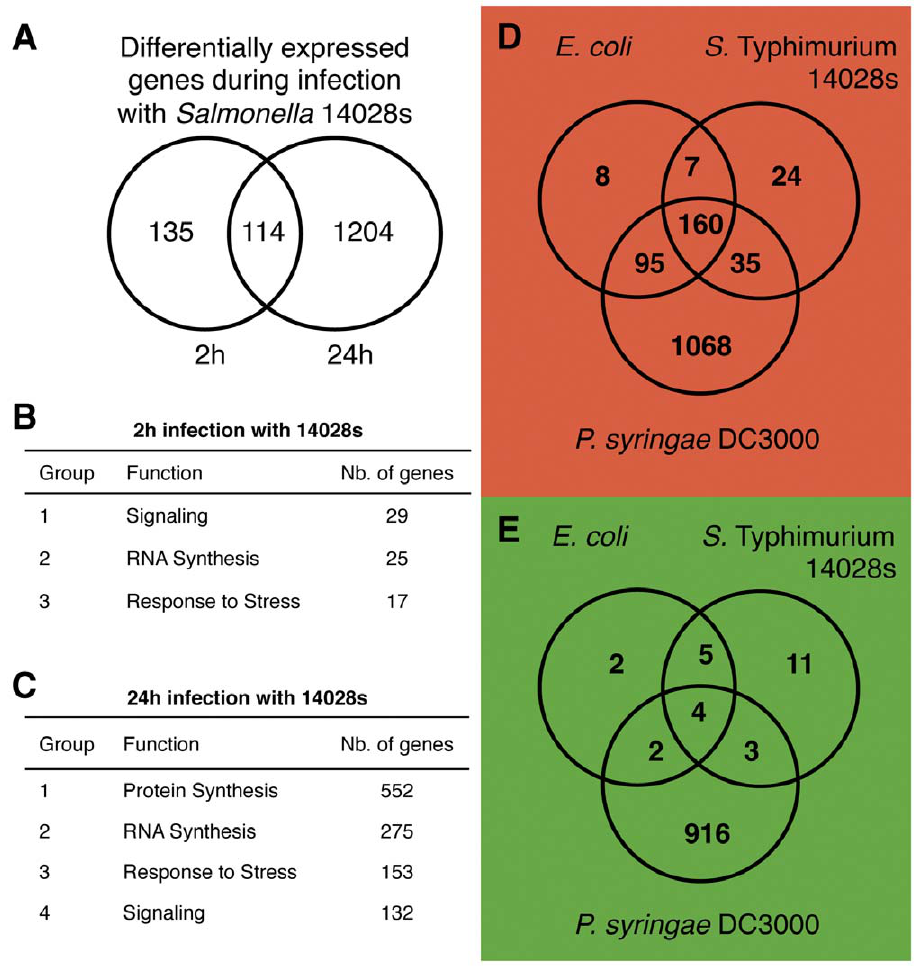
Figure 3. Transcriptional changes during plant infection with S. Typhimurium 14028 s, E.coli and Pseudomonassyringae . Fourteen-day old in vitro-grown Arabidopsis seedlings were placed in MS/2 liquid medium and inoculated with bacteria. Transcriptional analysis was performed at 2 or 24 h after inoculation using CATMA chips. Two biological replicates were hybridized and each hybridization was repeated with a dye-swap. Genes were considered to be differentially expressed only if they showed the same pattern in biological replicates, dye-swap and had p values , 0.05. For a complete list of differentially expressed genes see Supp. Data Set S1. A ; Overlap between genes differentially expressed at 2 and at 24 hours of infection. B–C ; Functional GO Term groups of genes differentially expressed at 2 h (B) and at 24 h (C) after infection. D–E ; Transcriptional analysis of plant responses to different bacteria. Fourteen-day old Arabidopsis seedlings were infected with S. Typhimurium strain 14028 s, E. coli DH5 a or P. syringae DC3000 for 2 h. D ; up-regulated genes. E ; down-regulated